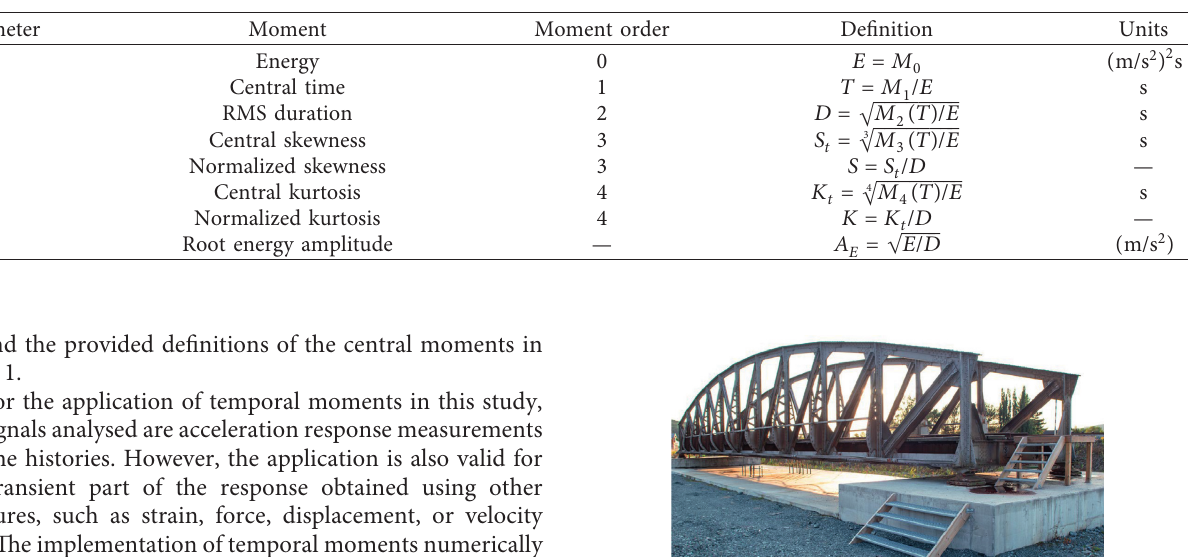
Table 1: Definition of central and normalized central